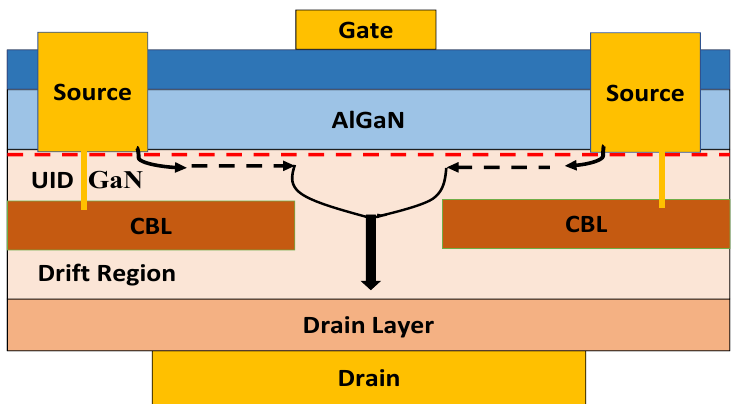
Figure 17. Vertical CAVET AlGaN/GaN HEMT structure. Reproduce from IOP science under the terms of the Creative Commons Attribution 3.0 license